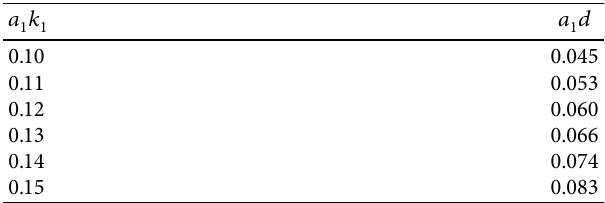
Figure 2: Energy distributions ( a 2 and wave steepness ( h s ) versus ( a energy distributions of Type 1 and 2. (b) Dimensionless angular frequencies of Type 2. (c) Equivalent wave height of Type 2. Table 2: Values of relative wave height at bifurcation points for incident waves with different slopes in the wave systems at